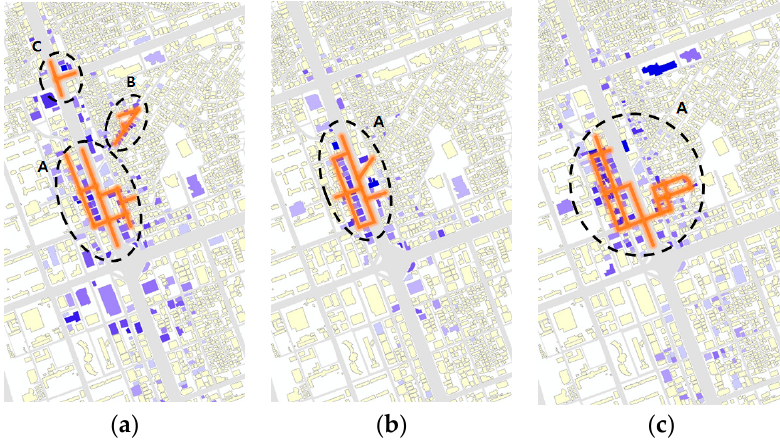
Figure 13. Themed street cluster detection results in Gangnam: ( a ) Café themed street; ( b ) Fashion themed street; ( c ) Pub themed street.